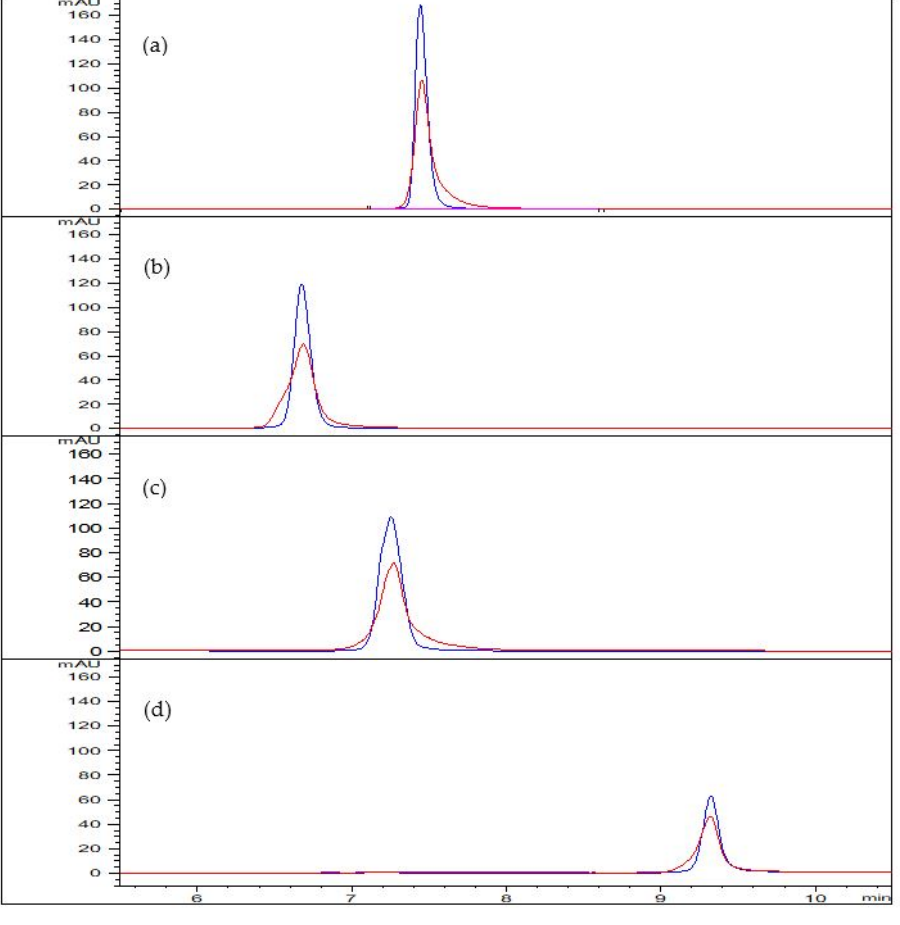
XB-C8 column, ( b ) Zorbax 300SB-C3 column, ( c ) BIOShell™ A400 Protein C18 column, and ( d ) Vydac ®